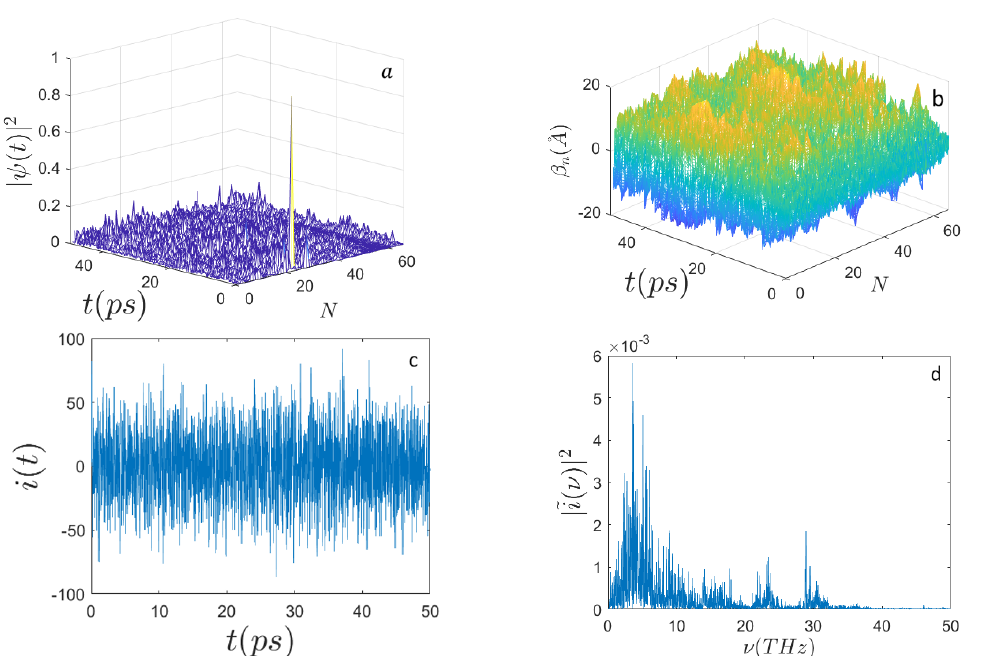
Figure 6. Time evolution of ( a ) the electron probability amplitude | Ψ ( t ) | 2 ; ( b ) the average displace- ments β n ( ˚ A ) ; ( c ) the electron current i ( t ) (expressed in µ biot); ( d ) the frequency spectrum | ˜ i ( ν ) | 2 along the sequence of N = 66 nucleotides with the initial conditions E 0 = 0.79 eV ( E (cid:48) = 120) and the initial electron excitation peaked around the site n 0 = N /3. The other parameters are the same as those in Figure